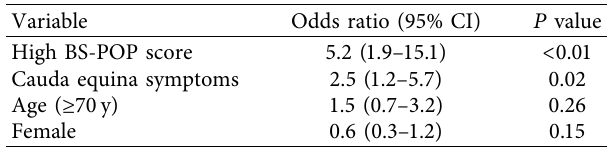
Table 4: Regression analysis of risk factors for low satisfaction with lumbar decompression